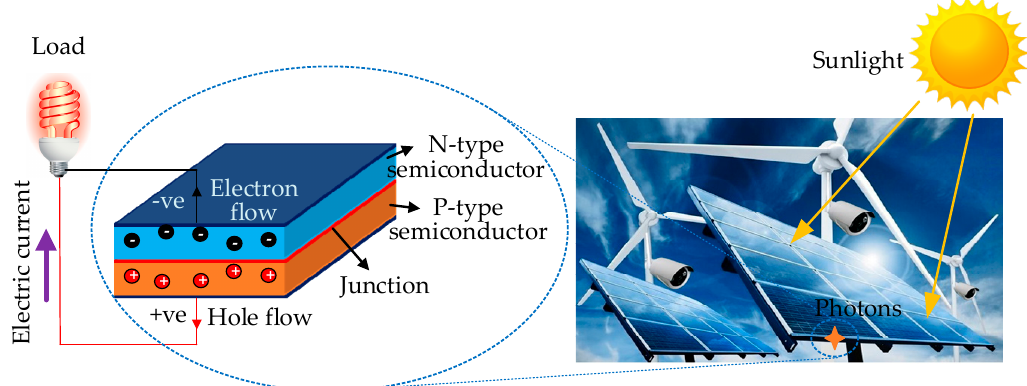
Figure 5. Working principle of photovoltaic cells.